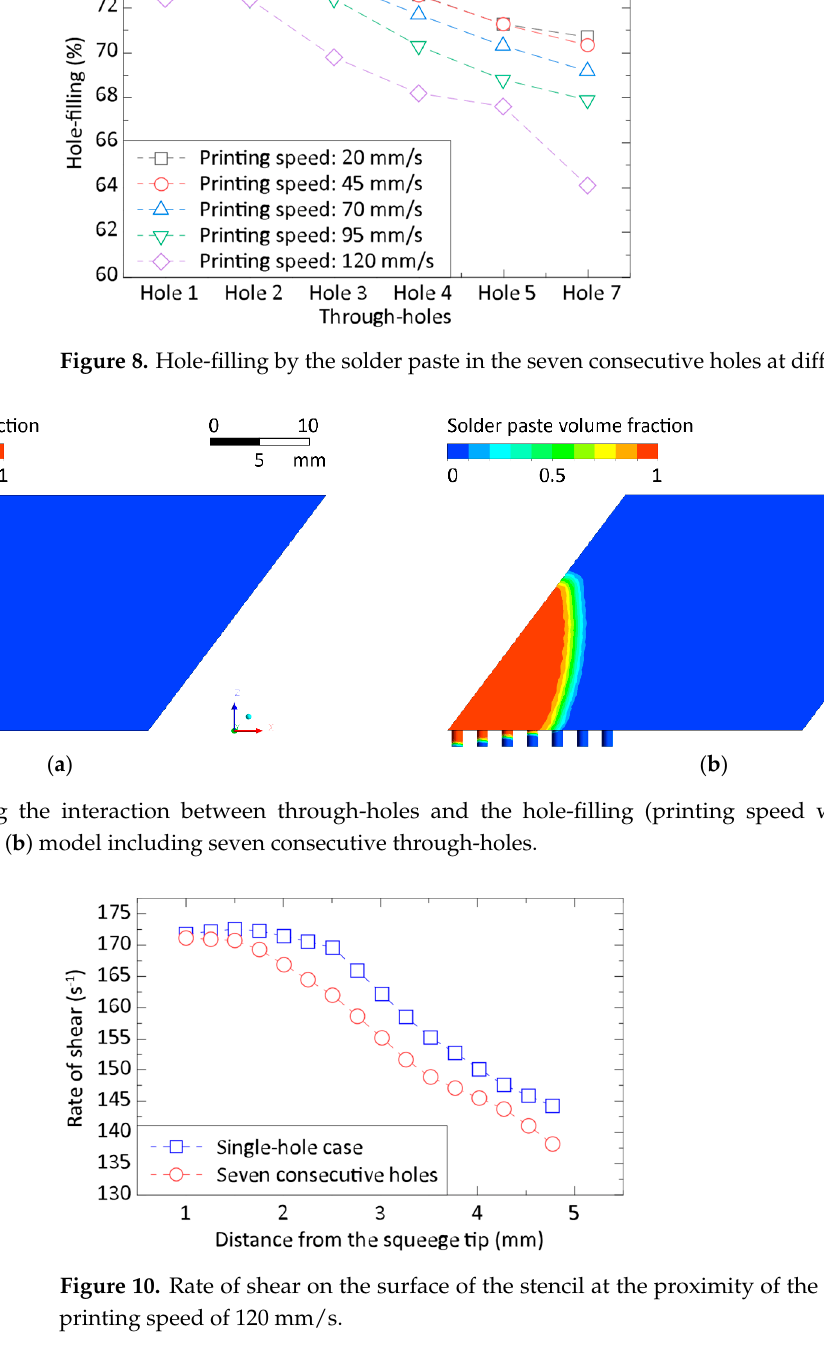
Figure 10. Rate of shear on the surface of the stencil at the proximity of the through-holes for the printing speed of 120 mm/s.